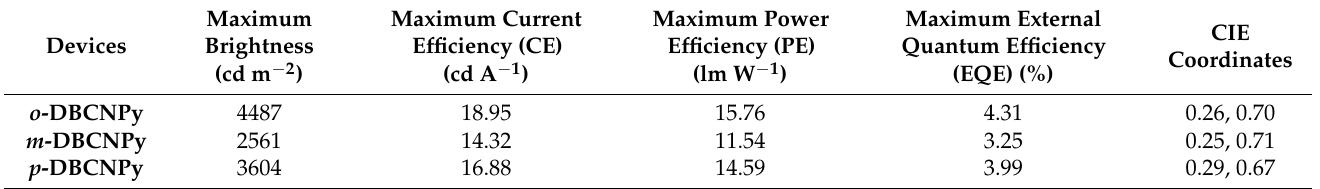
Figure 8. Current density–voltage–luminance ( J – V – L ) ( a ) and EQE-luminance characteristics ( b ) for the devices (inset showed the EL spectra). Table 4. Electroluminescence (EL) performance of non-doped OLEDs based on the molecules.